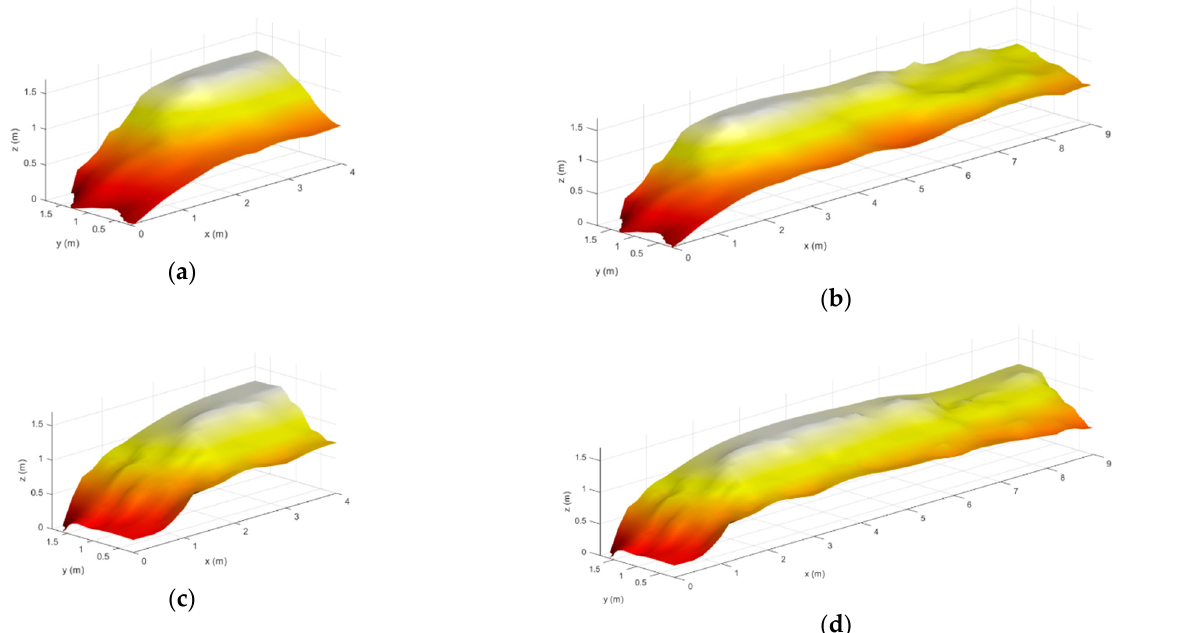
Figure 14. Reconstruction of the two real stockpiles when the scanner system is at ( a , c ) 4 m and ( b , d ) 9 m from the beginning of each stockpile.